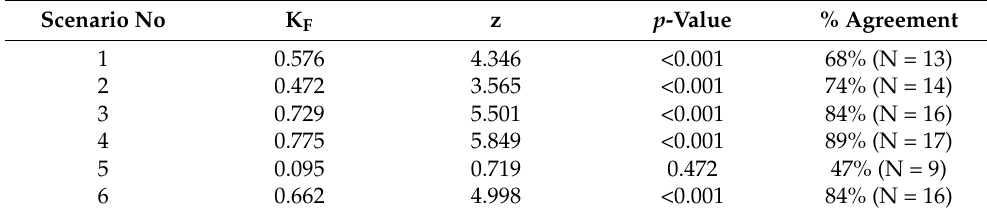
Table 3. Inter-rater reliability for HFACS-Eq Categories (19